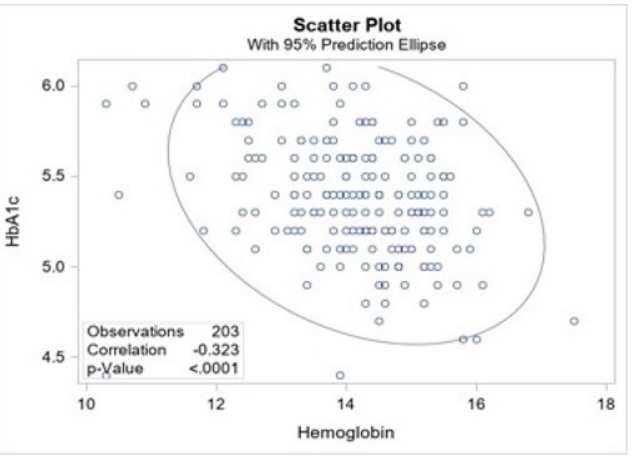
Figure 2. Scatter plot with 95% prediction ellipse depicting correlation between hemoglobin and HbA1c among 203 sugarcane